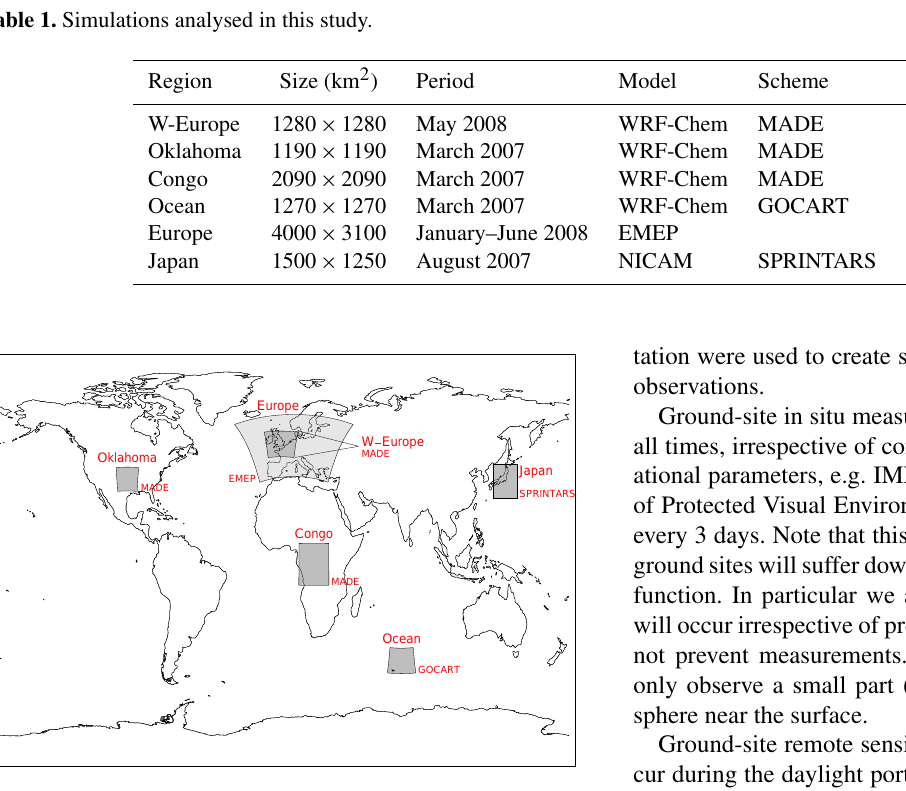
Figure 1. Three models were used in this study to simulate a variety of aerosol fields. The regional names used to identify these simula- tions are given in large font, while the models are denoted in small font. MADE and GOCART refer to the WRF-Chem version